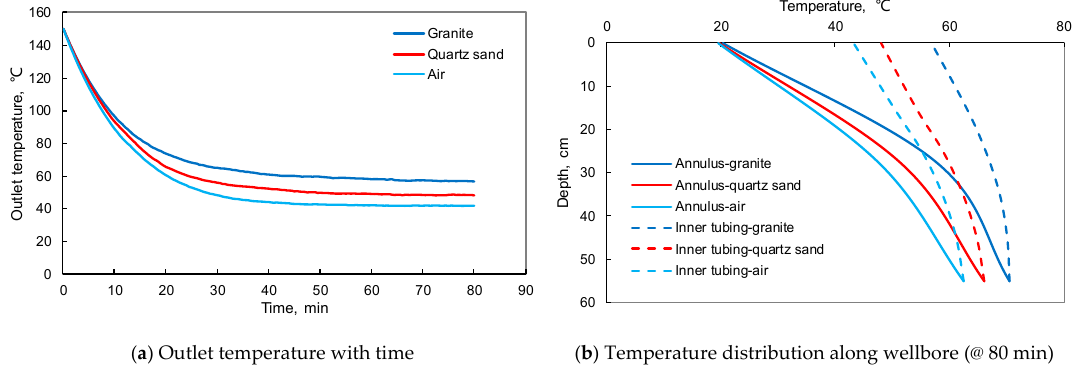
Figure 9. Temperatures at the outlet and along the wellbore under different reservoir types.